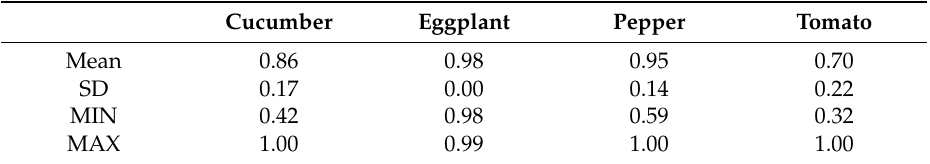
Table 6. DEA VRS results per